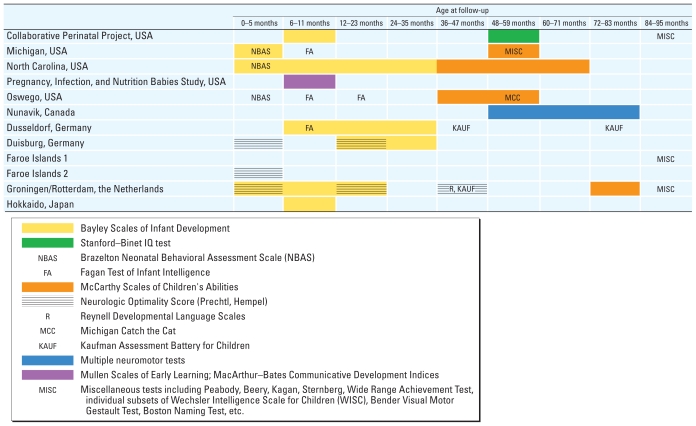
Summary of tests used in the PCB cohorts by age (for children up to 7 years of age at follow-up). Collaborative Perinatal Project, USA (Daniels et al. 2003); Michigan, USA (Jacobson et al. 1984); North Carolina, USA (Rogan et al. 1986); Pregnancy, Infection, and Nutrition Babies Study, USA, (Pan et al. 2009); Oswego, USA (Lonky et al. 1996); Nunavik, Canada (Després et al. 2005); Dusseldorf, Germany (Winneke et al. 1998); Duisburg, Germany (Wilhelm et al. 2008); Faroe Islands 1 (Grandjean et al. 2001); Faroe Islands 2 (Steuerwald et al. 2000); Groningen/Rotterdam, the Netherlands (Huisman et al. 1995a); Hokkaido, Japan (Nakajima et al. 2006). Additional testing was conducted with the Oswego cohort at 8 and 9 years of age, the Netherlands cohort at 9 years of age, and the Michigan cohort at 11 years of age.